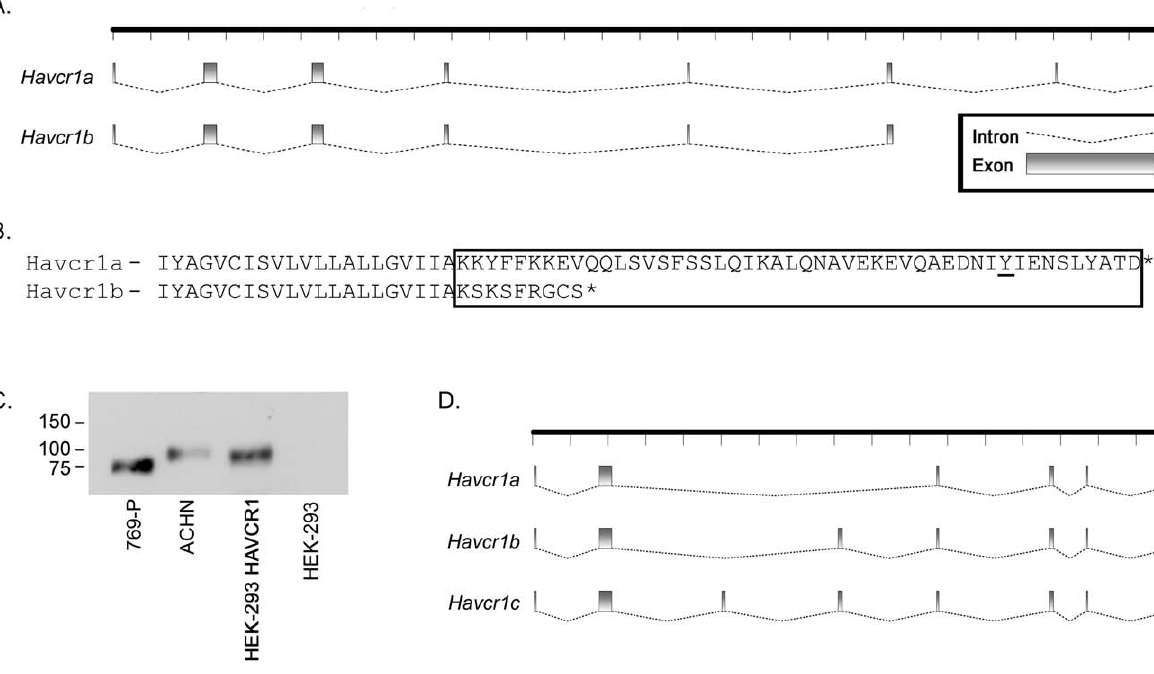
Figure 5. HAVCR1 splice variants. A . Full-length cDNAs were cloned and sequenced from e -toxin-sensitive ACHN cells ( HAVCR1a ) and from e -toxin-resistant 769-P cells ( HAVCR1a and HAVCR1b ). The coding-exon structure for each transcript is illustrated. B . Partial amino acid sequences of the HAVCR1a and HAVCR1b proteins are shown; the putative cytoplasmic domains are boxed. A conserved tyrosine present in HAVCR1a, shown previously to become phosphorylated, is underlined [44,45]. C . Whole-cell lysates were prepared from e -toxin-sensitive ACHN, from e -toxin-resistant 769-P and HEK-293 cells, and from HEK-293 cells transfected with a vector expressing HAVCR1a from ACHN cells and analyzed by immunoblot analysis using an anti-HAVCR1 antibody. D . Full-length cDNAs were cloned and sequenced from e -toxin-sensitive MDCK cells. The coding-exon structures for the three transcripts are illustrated as in ‘‘A’’. doi:10.1371/journal.pone.0017787.g005 PLoS ONE |